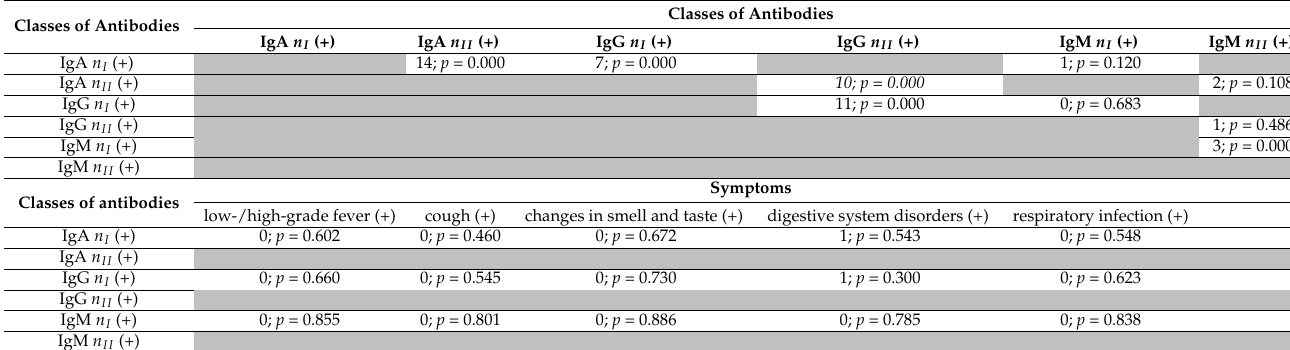
Table 5. Observed number of individuals antibody-positive in different classes and analysis of the relationships between antibody classes and reported symptoms. Classes of